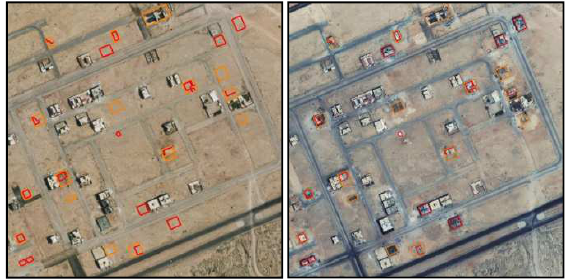
Figure 9. Updated map overlaid with aerial orthophoto from 2007 (left) and IKONOS orthophoto of 2008 used for mapping (right)